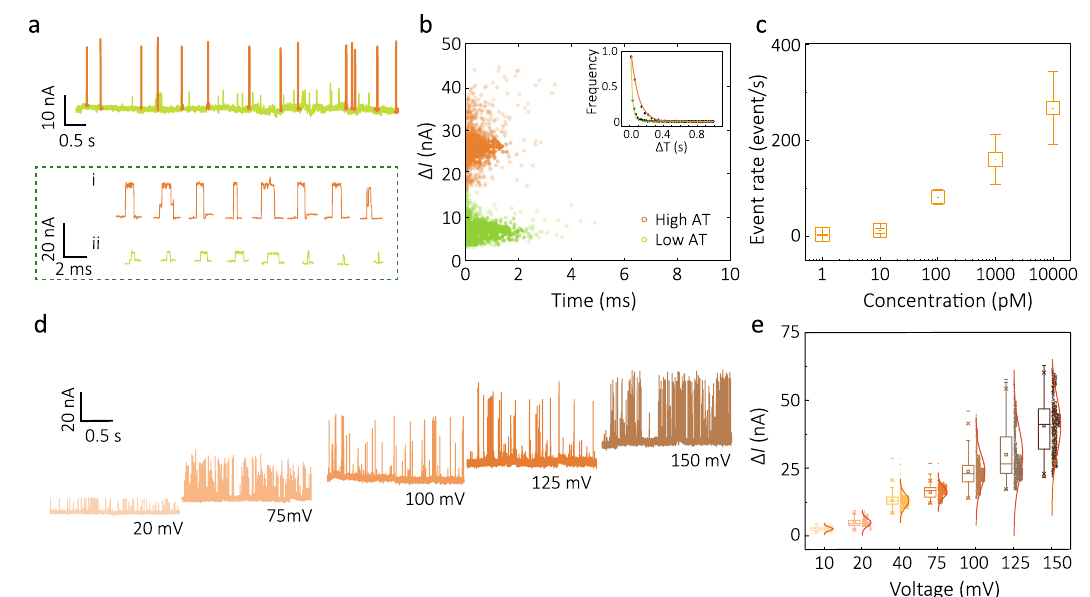
Fig. 3 QMT detection of single-stranded DNA. a Representative tunnelling current – time trace for 100 pM poly-A20 DNA using a QMT probe with a gap width of ~1.7 nm at an applied bias of 100 mV. Transient current increase indicates a single DNA molecule residing between the tunnelling junction. Both high amplitude (orange) and low amplitude transients (green) are visible above the baseline current. b Scatter plots for transient time vs change in current for both high amplitude (orange) and low amplitude transients. The inset shows a histogram for the time between events for both classes of transients, respectively, which could be fi tted as single exponential distribution, consistent with single-molecule events. c Plot of event rate of the high amplitude transients events vs analyte concentrations (1 pM, 10 pM, 100 pM, 1 nM, and 10 nM). d Representative tunnelling current traces for the same QMT probe under different bias in the presence of 100 pM poly-A20 DNA. e Histogram and f statistics analysis of peak current for high amplitude transients at a different bias (10 – 150 mV). All error bars represent 1 standard deviation from the